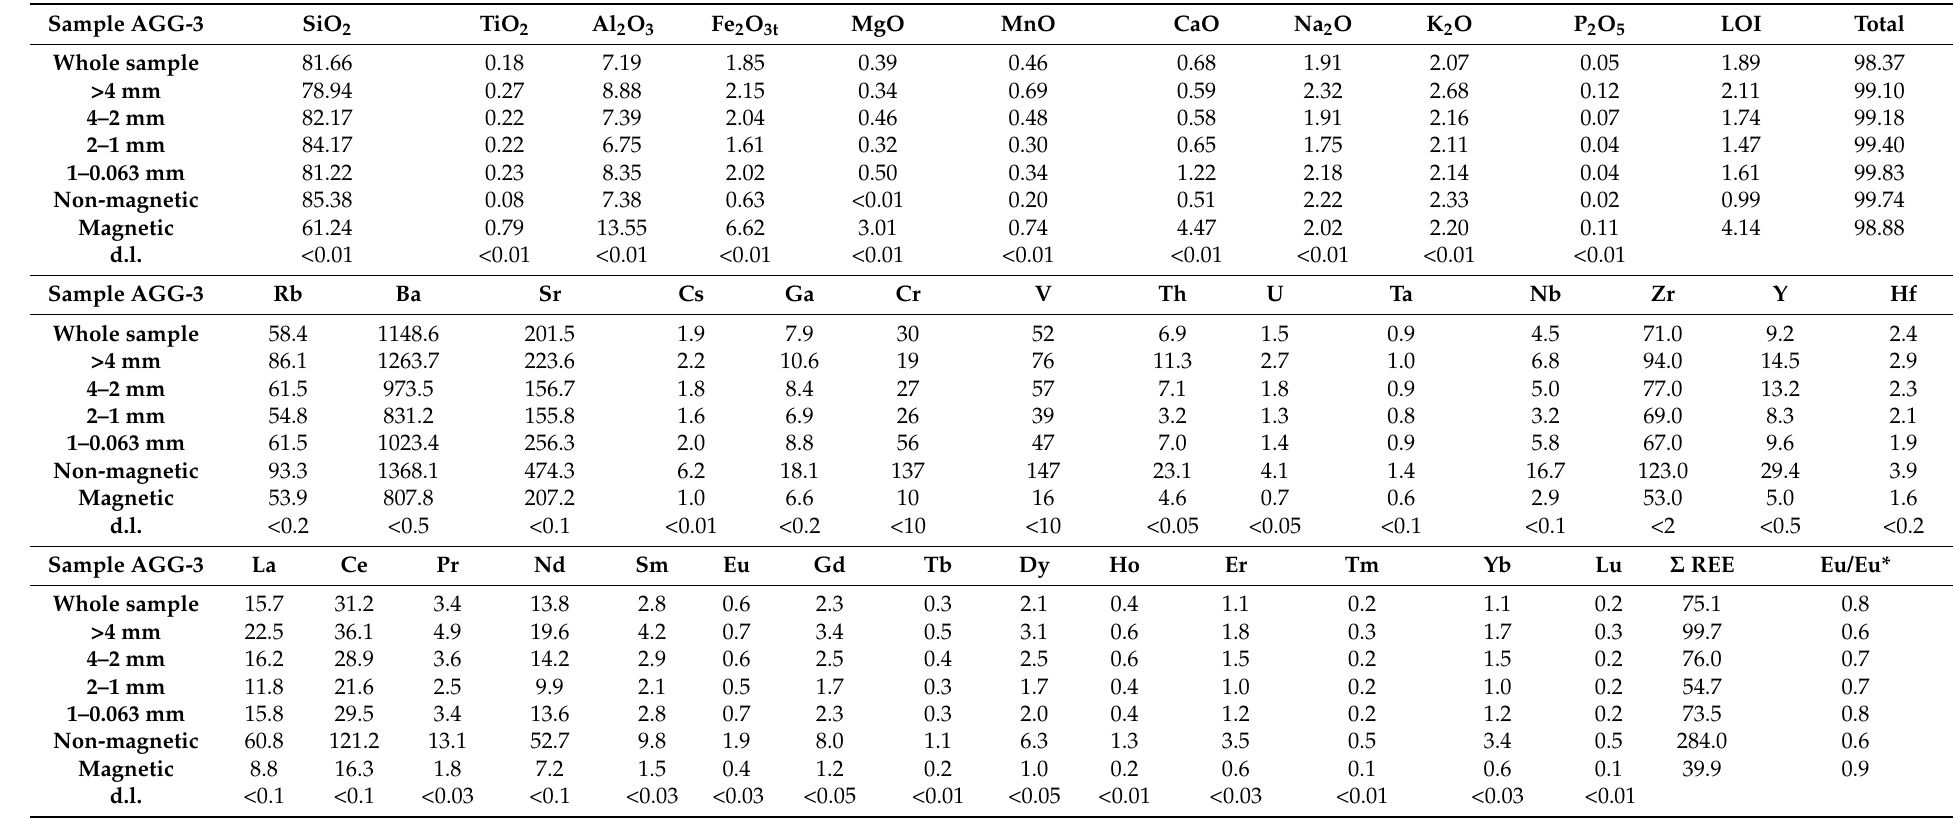
Table 4. Major and trace element composition of several fractions of the sample